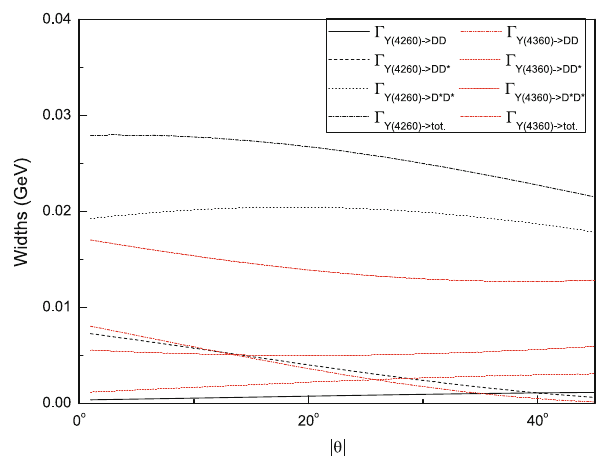
Fig. 5 Decay widths of Y ( 4260 ) and Y ( 4360 ) as functions of the mix- ( ∗ ) ¯ D ( ∗ ) ing angle. The widths of D s s are not plotted for they are gen- erally small. The subscript “tot.” in the plot means summation of the D ( ∗ ) ¯ D ( ∗ ) , D ( ∗ ) s ¯ D ( ∗ ) s